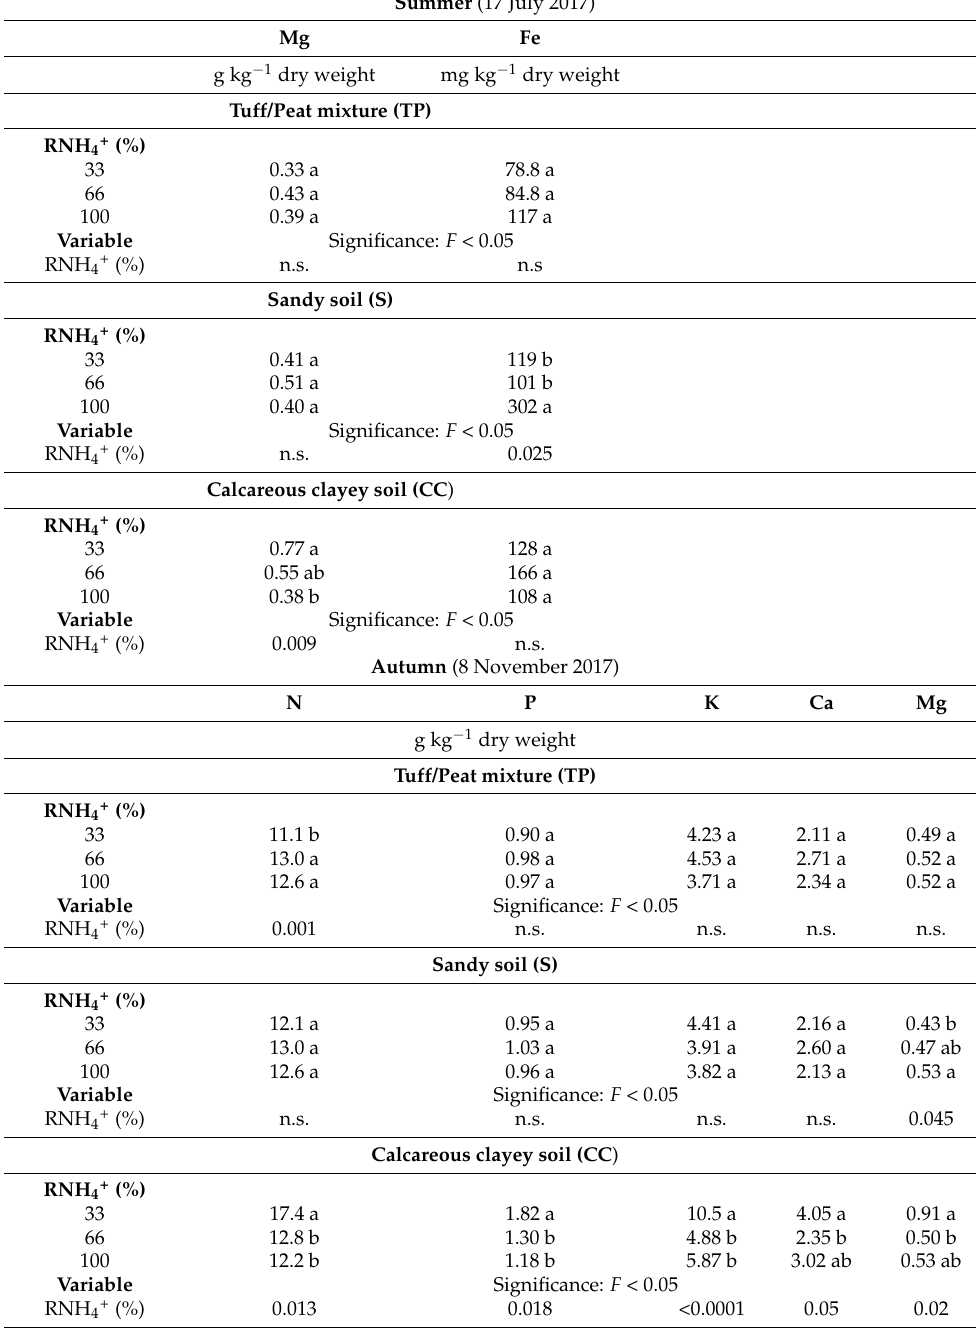
Table 7. Analysis of the effects of each growth medium [tuff/peat mixture (TP), sandy soil (S) and calcareous, clayey soil (CC)] and the proportion of N-NH 4+ among the total applied inorganic N (RNH 4+ ) [RNH 4+ = 100 × N-NH 4+ /(N-NH 4+ +N-NO 3 − )] on the nutrient concentrations in the diagnostic leaves of rabbiteye blueberry plants ( Vaccinium virgatum Ait., cv. Ochlockonee). The interactions between the treatments significantly affected Mg and Fe levels at the summer sampling time (17 July 2017; probability of F = 0.0008 and <0.0001, respectively, Table 6), as well as the levels of N, P, K, Ca and Mg at the autumn sampling time (8 November 2017; probability of F = 0.0007, 0.002, <0.0001, 0.018 and 0.003, respectively, Table